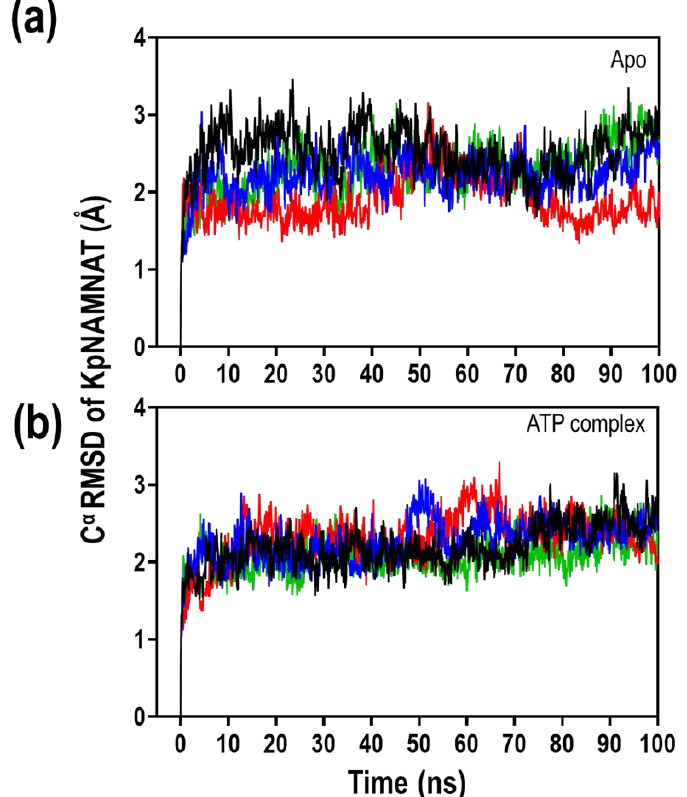
Figure 6. The root-mean-square deviation (RMSD) of the C α atoms of KpNNAT over 100 ns simulation time. Analysis of KpNNAT apo and KpNNAT-ATP complex in the absence (black) and presence of Mg 2+ (blue), Ca 2+ (red), and Zn 2+ (green). The fluctuation change for all systems is within 3 Å and stabilises within a fixed value at the end of the simulation. The plots were generated using GraphPad